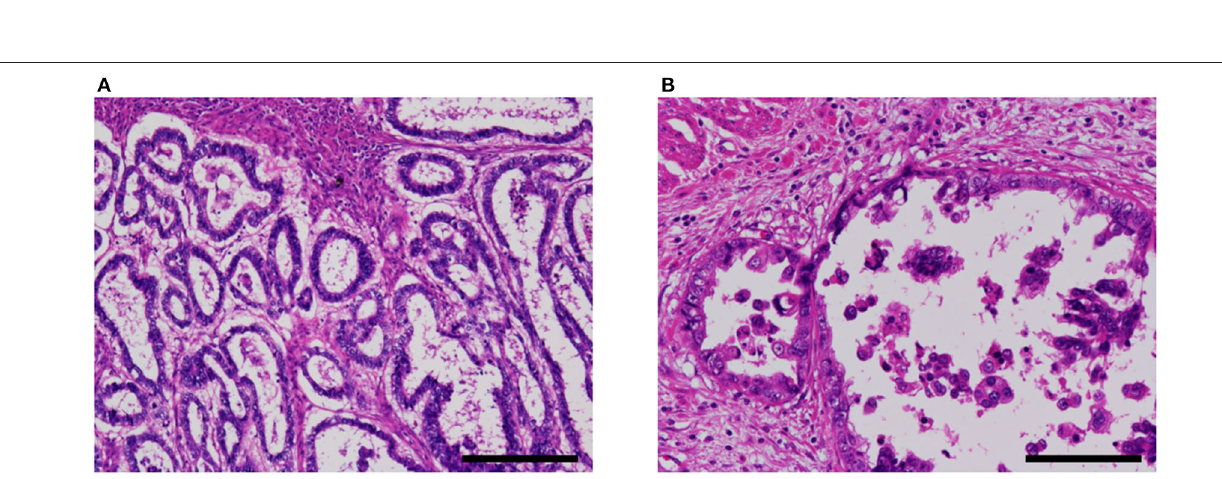
Frontiers in Medicine |